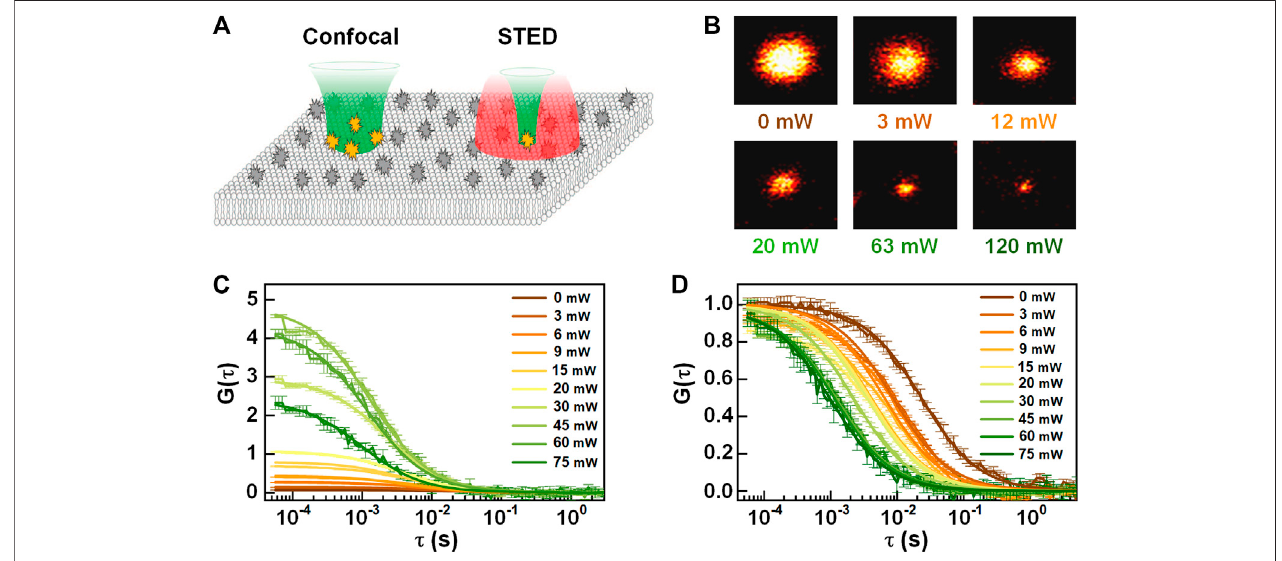
FIGURE9| SchematicdiagramofSTED-FCS.( A )Theobservationvolumeofconfocal (left) andSTED (right) .AdaptedfromRef.[100].( B )Theeffectivefocussize (STED image of a single particle) at the different intensity of the depletion light. ( C ) Autocorrelation and ( D ) normalized autocorrelation curves of STED-FCS at different depletion